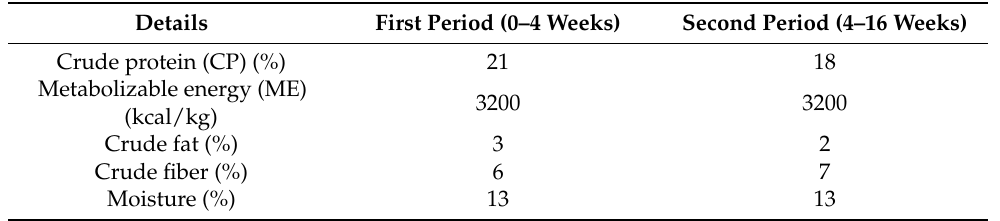
Table 1. Commercial diets formulated for the native